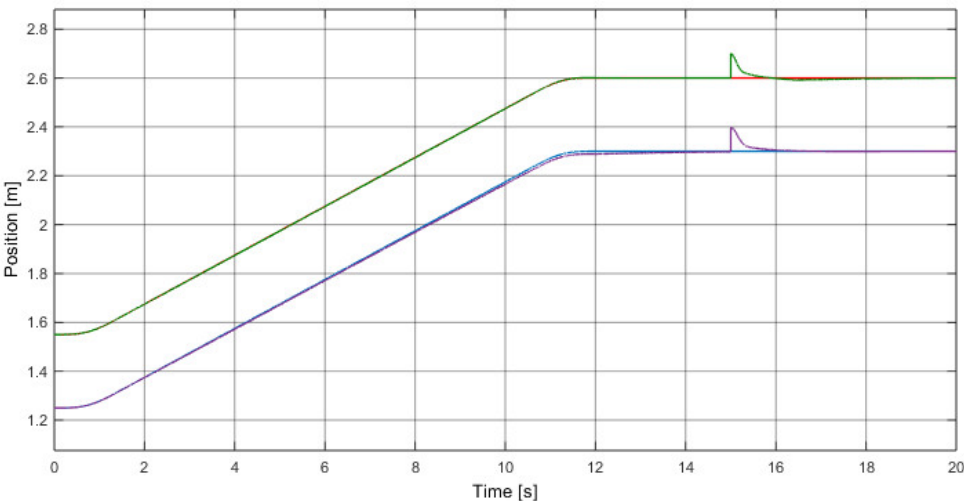
Figure 27. Positioning response of the planar CDPR (away from the center) with disturbance at 15 s of simulation, with a PID controller.